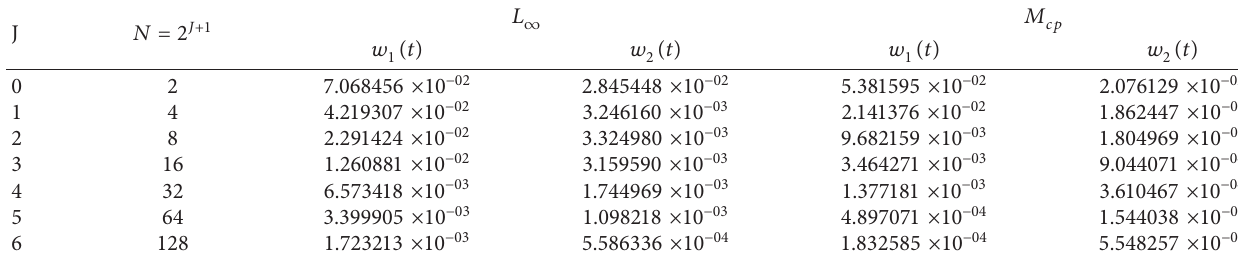
Table 3: L and M cp errors for Problem 3. ∞